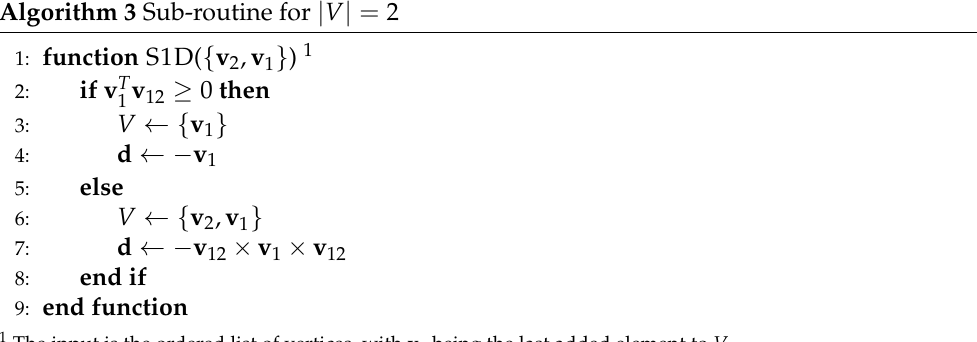
Algorithm 3 Sub-routine for | V | =